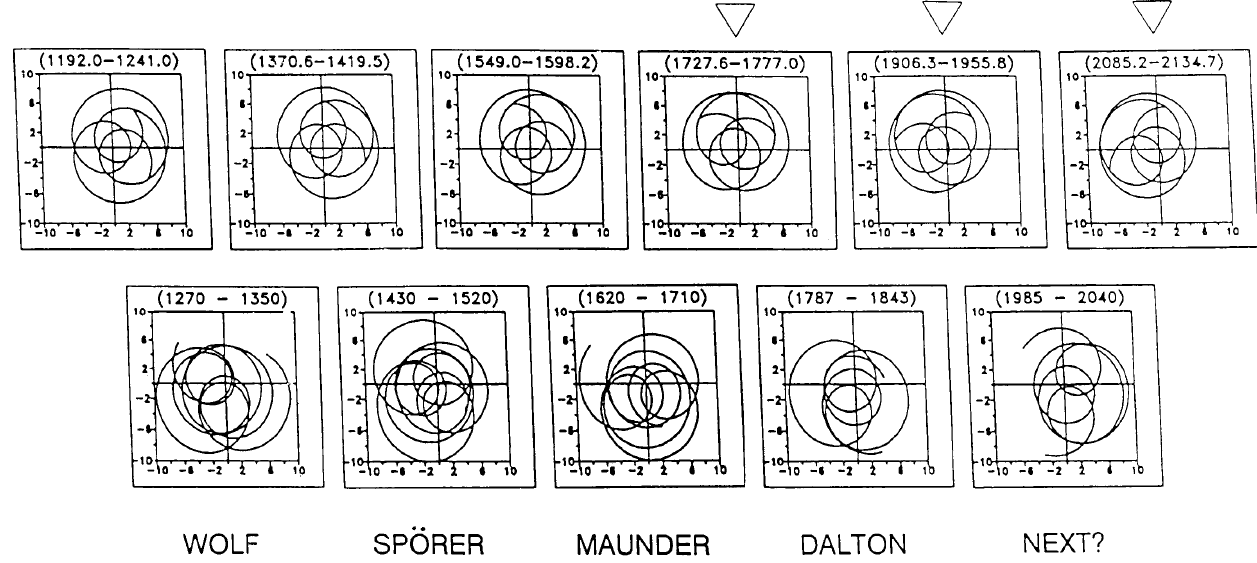
Fig. 2. The orbit of the centre of the Sun around the centre of mass of the solar system (in units of 10 ) 3 AU) separated into two basic types, the ordered (in a JS-trefoil) ( top ) and the disordered ( bottom ). The area in which the Sun moves has a diameter of 0.02 AU or 4.4 r being the solar radius, or 3 Æ 10 6 km. The most disordered sections of the intervals lying between the trefoils are plotted. The Sun enters into the trefoils with a periodicity of 178.7 years, on the average (see the times, years at the top of the respective figures). The value represents